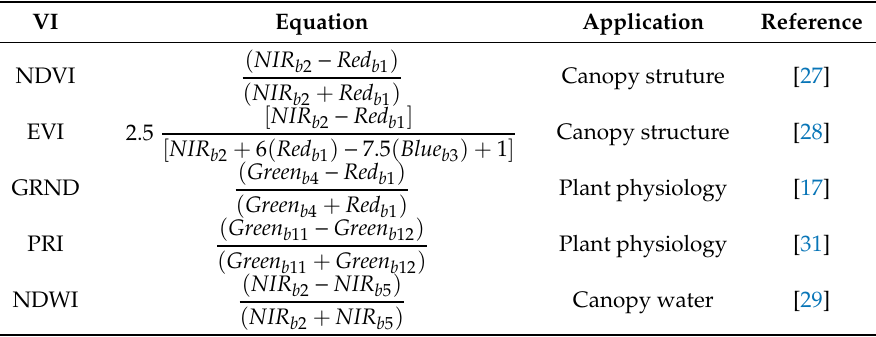
Table 2. Selected vegetation indices (VIs) for the analysis of their sensitivity to bidirectional e ff ects. The MODIS reflectance bands used in the calculations are indicated and their wavelength positions are shown in the